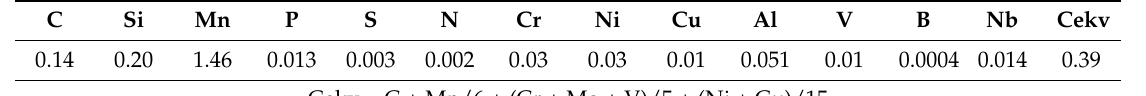
Table 1. Chemical composition of the studied DP 1000 steel in wt %.